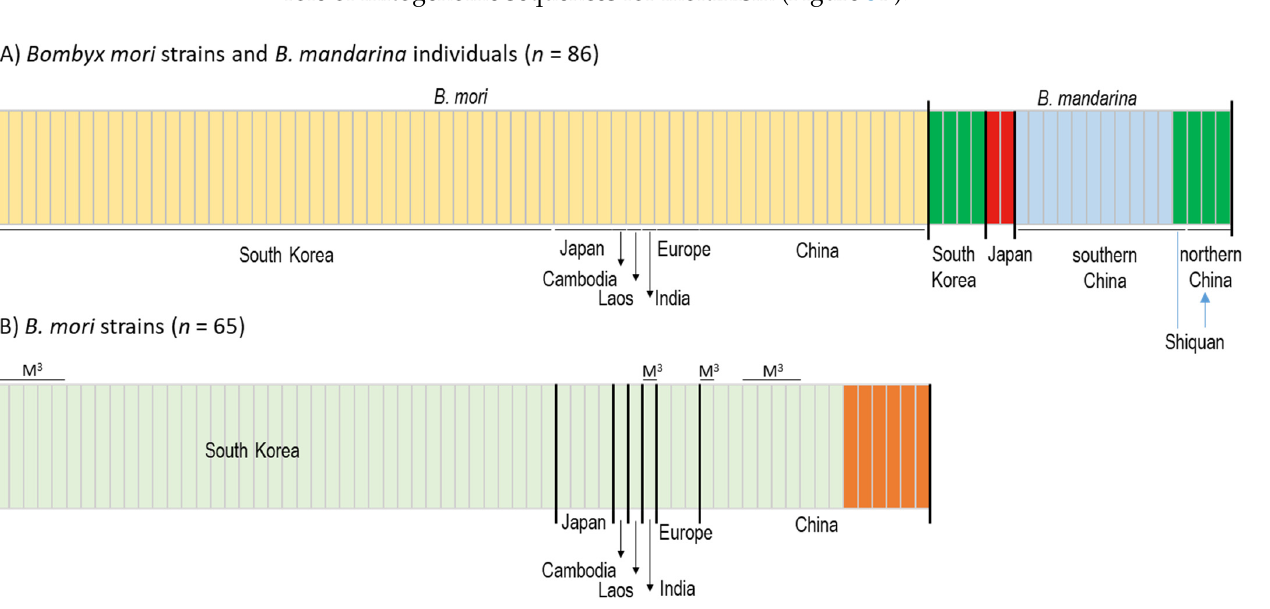
Figure 3. Bayesian clustering analysis. ( A ) Analysis including both Bombyx mori strains and B. mandarina individuals under the optimum number of clusters ( K ) of 4. ( B ) Analysis including only B. mori strains under the optimum number of clusters ( K ) of 2. B. mori strains marked with M 3 are trimolters, whereas the remaining strains are tetramolters. Each vertical bar represents an individual and its associated probability of belonging to the assigned cluster.